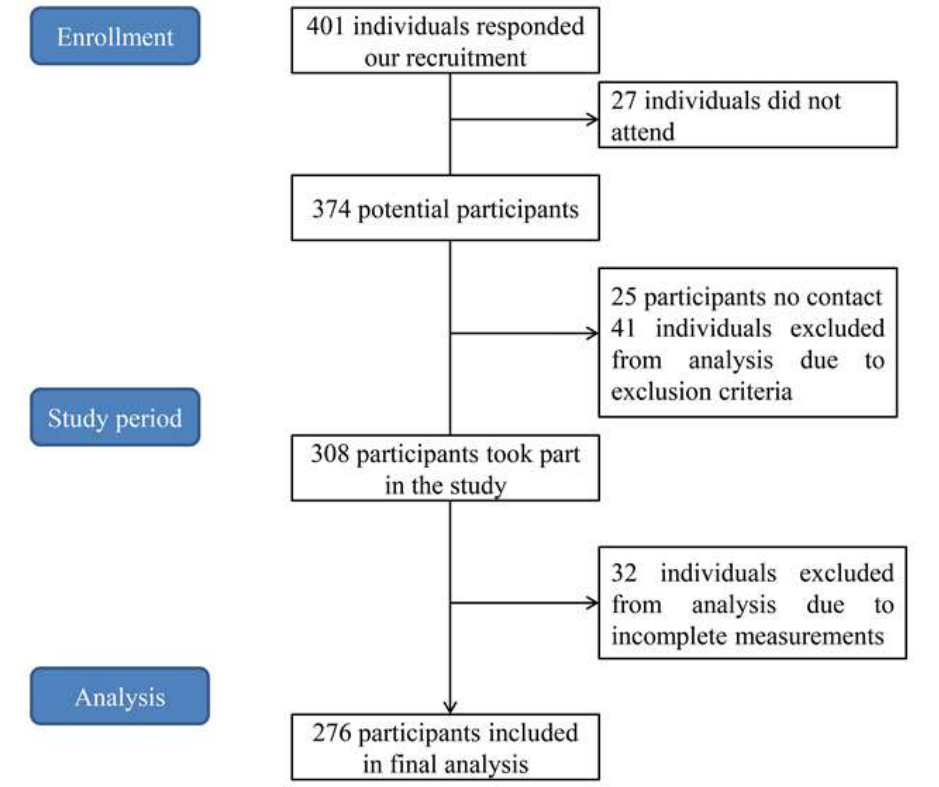
Figure 1. The flow diagram of the participants inclusion.